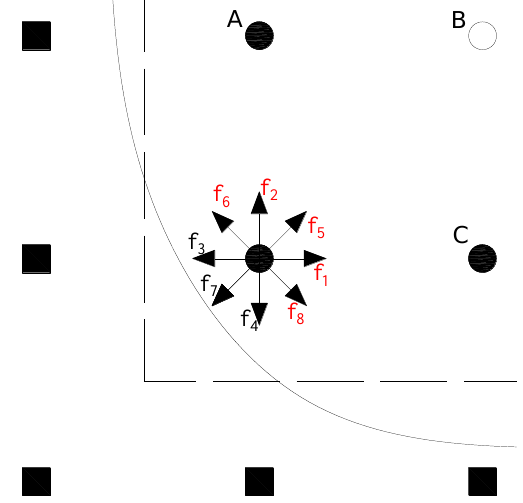
Figure 5. Fluid, boundary, and solid nodes near a curved wall. The solid square, the solid circle, and the hollow circle denotes the solid nodes, boundary nodes, and the fluid nodes, respectively. The curved line is the wall in reality, and the dash line represent the boundary in the simulation.